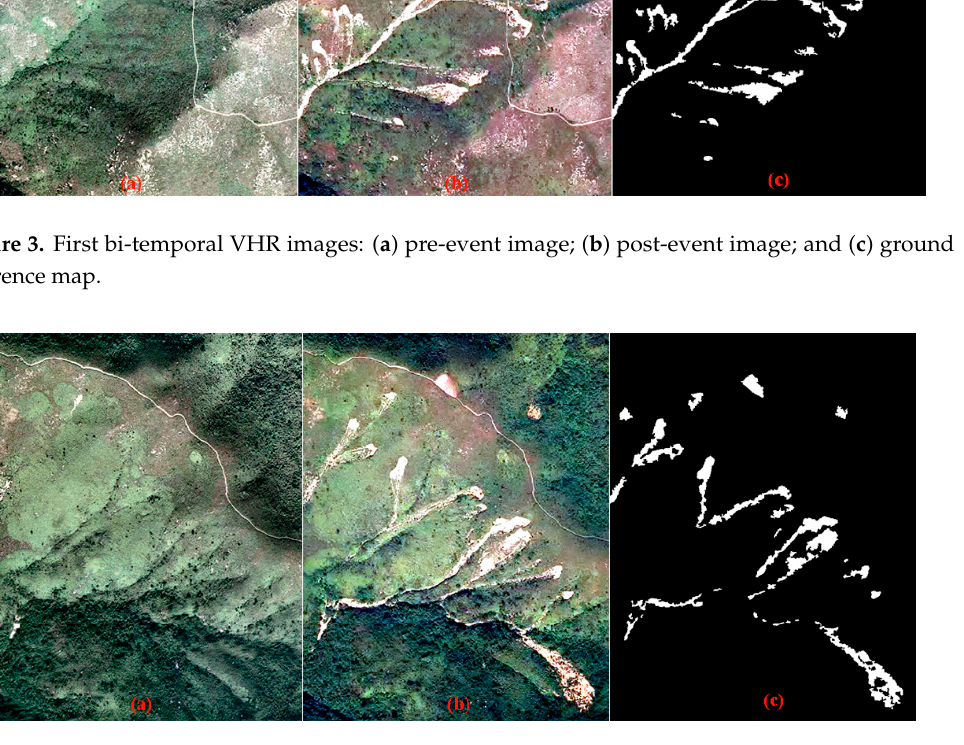
Figure 4. Second bi-temporal VHR images: ( a ) pre-event image; ( b ) post-event image; and ( c ) ground reference map.